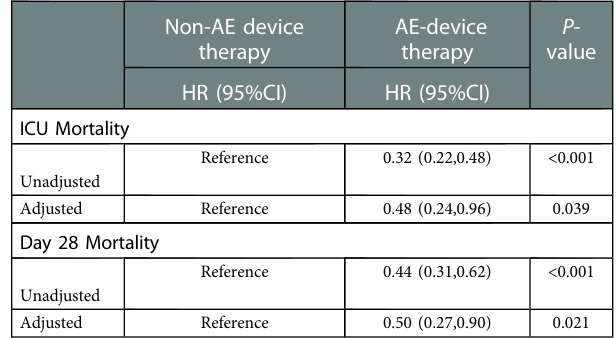
TABLE 2 Analysis of the associations between AE-device therapy and outcomes. Analysis of the associations between AE-device therapy and